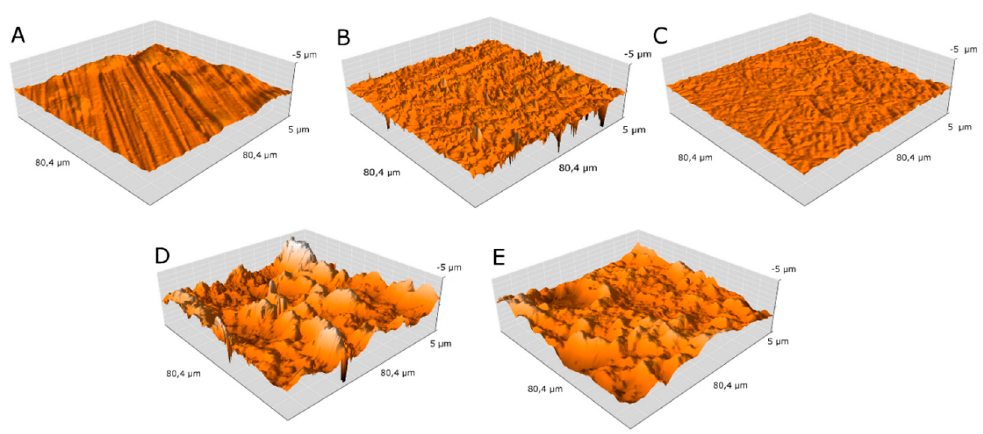
Figure 1. Atomic force microscope (AFM) surface topography of the: ( A ) reference sample—native material after grinding (MR), ( B ) reference sample—after etching (MRe), ( C ) sample of carbon nanotubes (0.27CNT), ( D ) sample of carbon nanotubes deposited on the nanohydroxyapatite layer(H0.27CNT), ( E ) sample of composite of carbon nanotubes, nanohydroxyapatite, nanosilver and nanocopper (m0.4CNT).